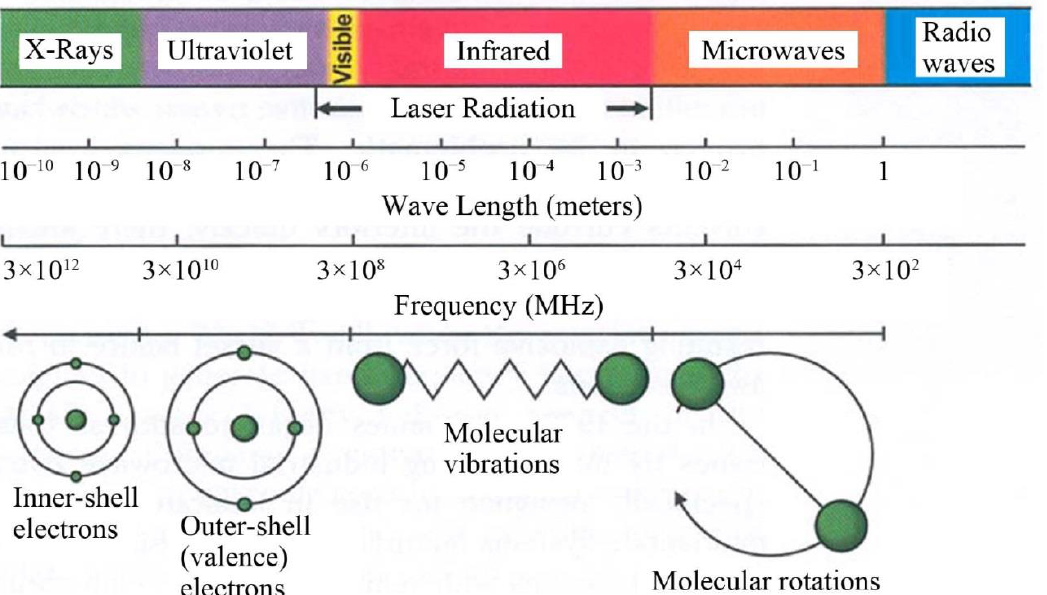
(Figure 8): absorption, transmission and reflection. Polar substances (e.g., solvents: H 2 O, ethylene glycol) absorb microwave radiation, as a result of which they are heated. Non-polar substances may display low interactions with microwave radiation, for which they are a microwave transparent medium. The third type includes substances (electrical conductors, e.g., metals) which reflect the microwave radiation from their surface.